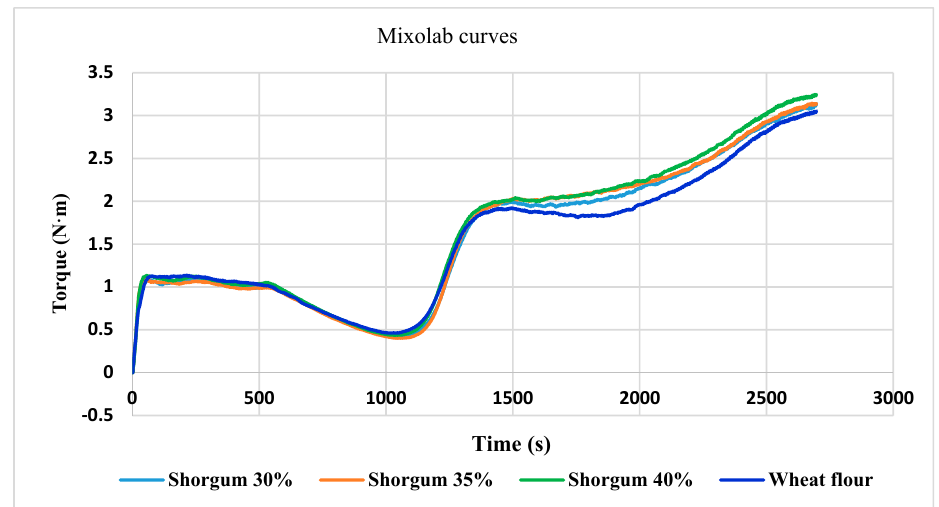
Figure 5. The influence of substitution level of sorghum flour on the Mixolab curves.